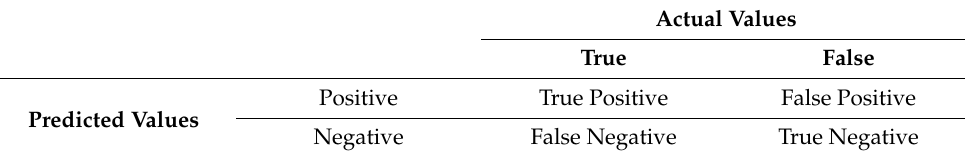
Table 1. Confusion